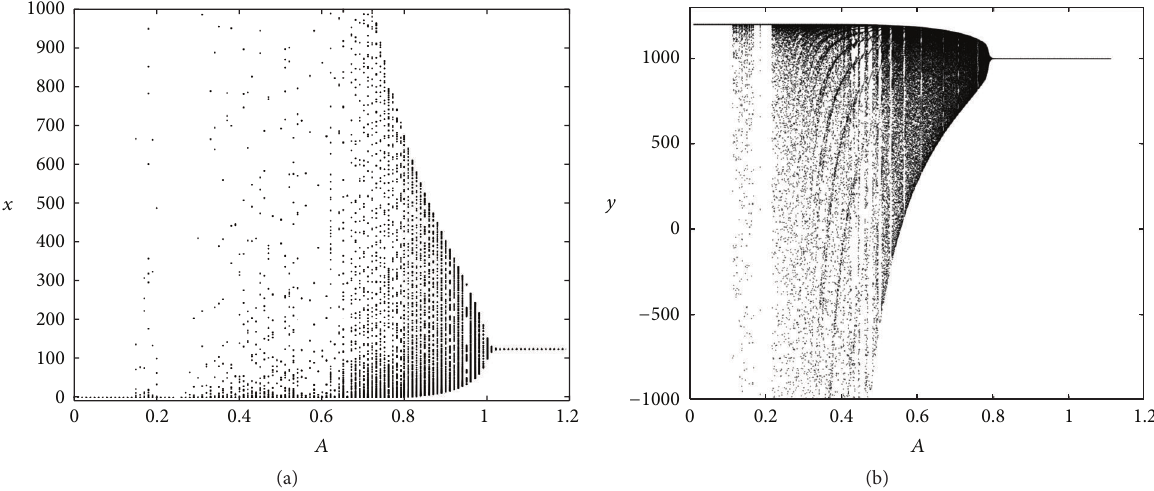
Figure 10: Diagrams of bifurcation of the equilibrium points with respect to 𝑥 (a) and 𝑦 (b), for the parameter 𝐴 varying from 0 to 1.2, = 0.1 , 𝑦 = 𝑠 for 𝑠 = 1250 , 𝑇 = 1000 , 𝛼 = 0.5 , and 𝑘 = 4 . 𝑥 1 1